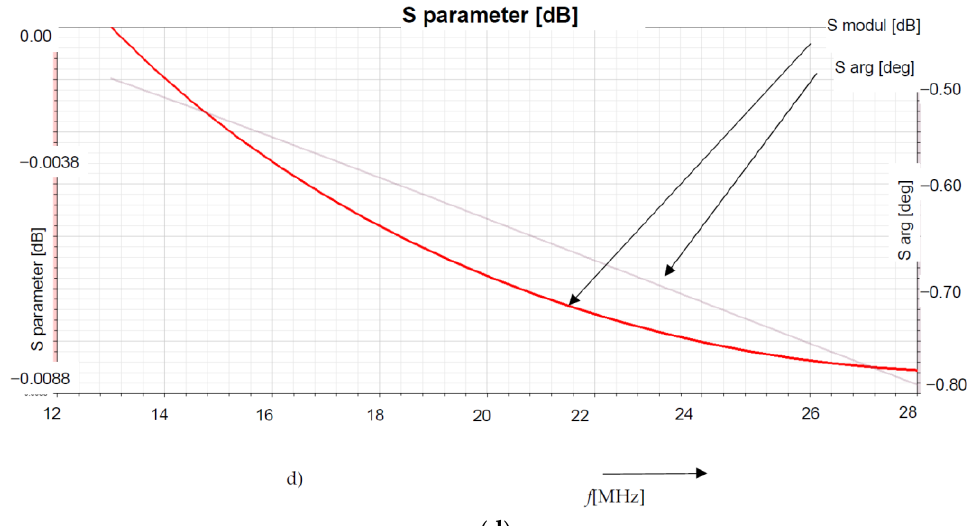
Figure 2. The geometrical arrangement of the plasma channel, single-turn electrode, external medium, and bottom metal plate: ( a ) the geometrical model; ( b ) the distribution of the volume loss density P vol [Wm −3 ], f = 13.56 MHz; ( c ) the distribution of the intensity of the electric field E [Vm −1 ], f = 13.56 MHz; ( d ) parameter s 11mod , f = 10 MHz – 28 MHz.